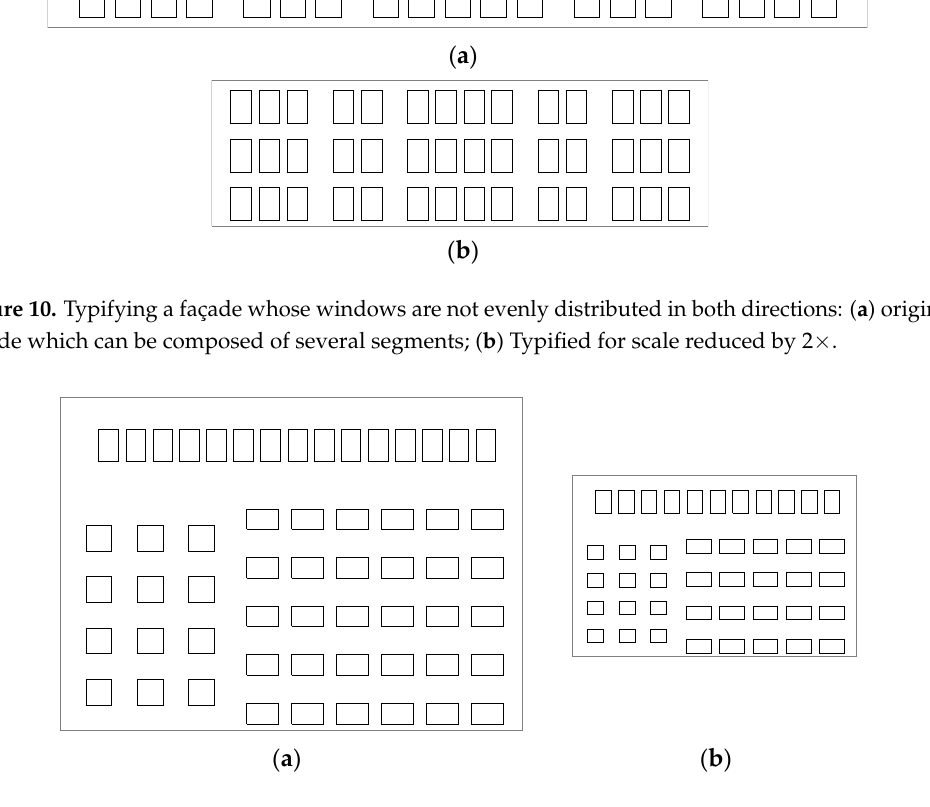
Figure 11. Typifying a façade, in which the windows are distributed irregularly: ( a ) original façade which can be composed of several segments; ( b ) for scale reduced by 2×.